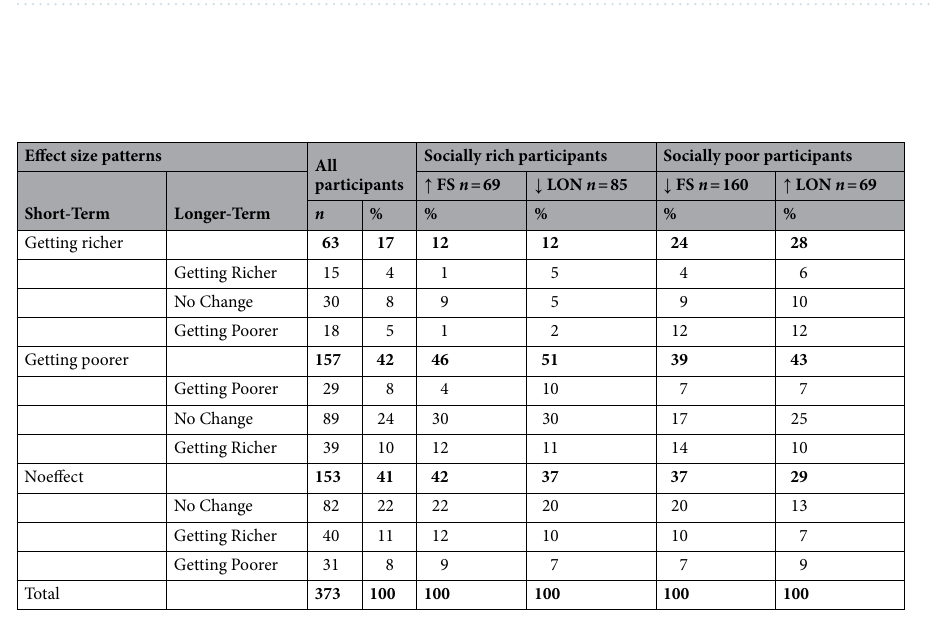
Table 4. Distribution of N = 1 effect sizes among socially rich and socially poor adolescents. ↑ FS = high on friendship support; ↓ LON = low on loneliness; ↓ FS = low on friendship support; ↑ LON = high on loneliness. Effects were considered as negative/positive based on the cut-off points β ≤ − .05 and β ≥ .05. Subgroups of socially rich and poor adolescents were created based on the Mean + /1 SD, with the exception of low loneliness for which we used the absolute minimum of